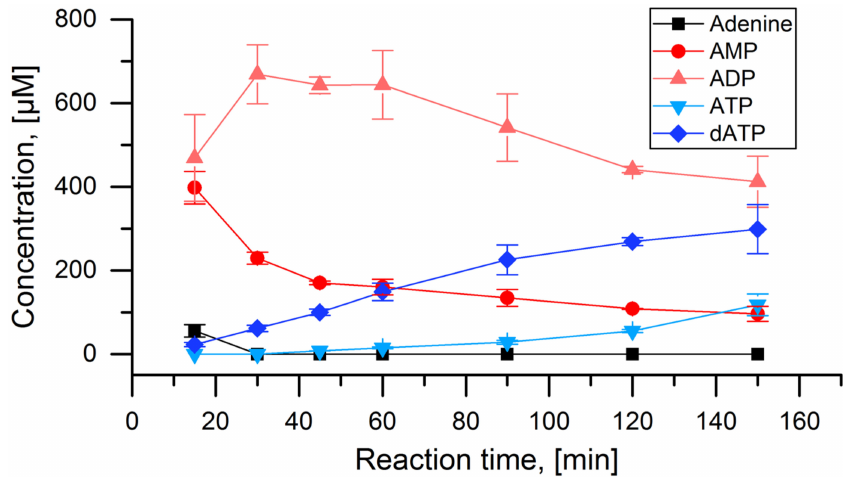
Figure 3. Test of the APT-PPK-RNR reaction cascade with adenine: Concentrations of adenine and all detected adenosine nucleotides over the time course of the full cascade reaction with 1 mmol L − 1 adenine as initial substrate. Applied enzyme concentration: APT: 10 nmol L − 1 , PPK: 40 nmol L − 1 , RNR: 2 µ mol L − 1